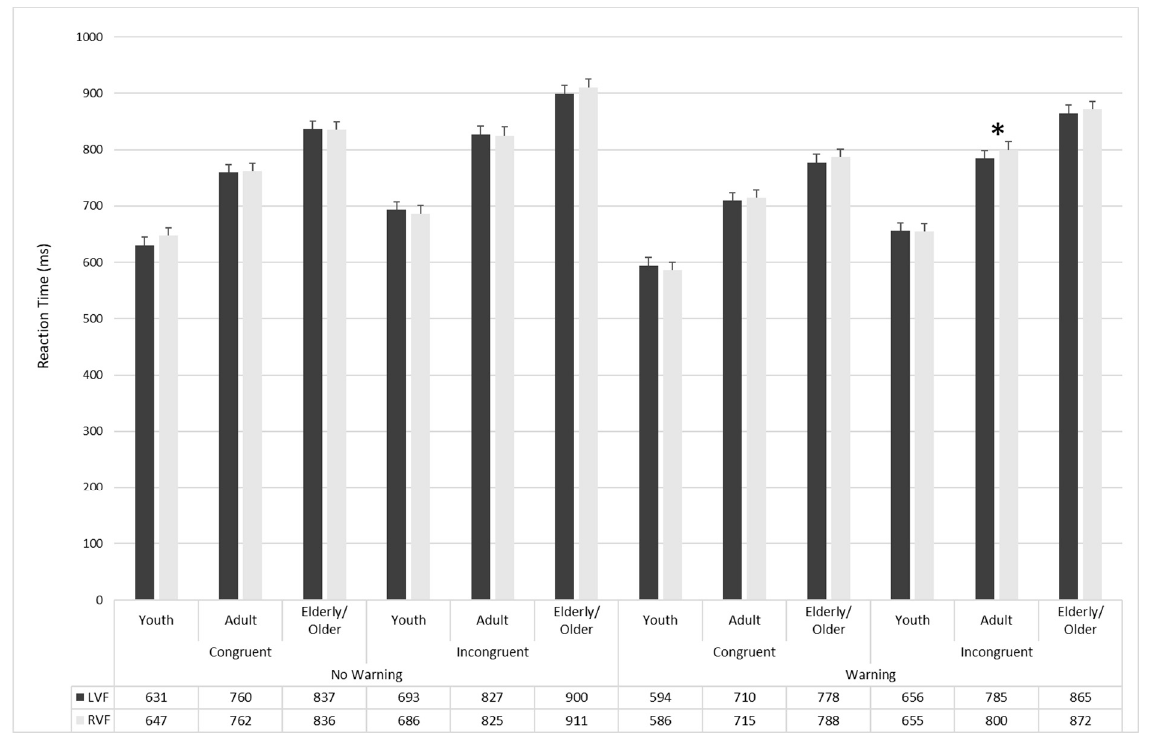
Figure 3. Main reaction times (in milliseconds) for the three age groups in the LVF and RVF as a function of warning and flanker types. *: p < 0.05.